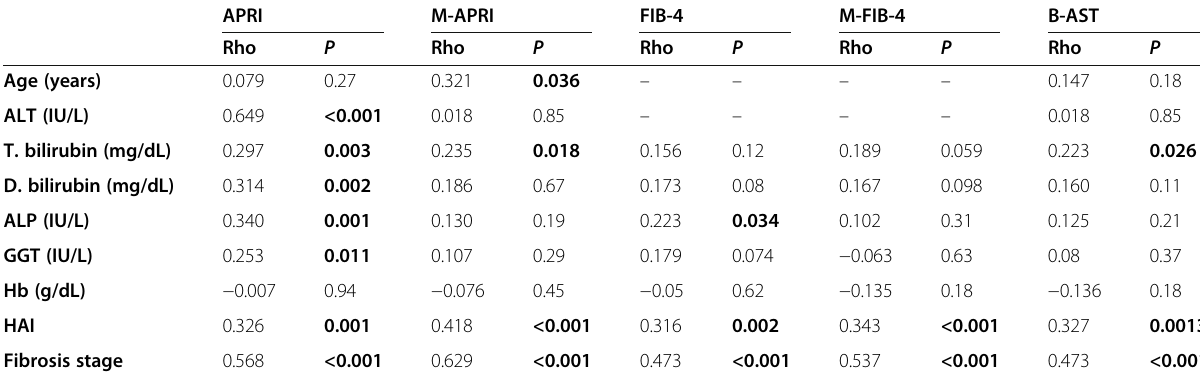
Table 4 Correlation between the non-invasive biomarkers and lab investigations and histopathological evaluation in the study group APRI Age (years) 0.649 <0.001